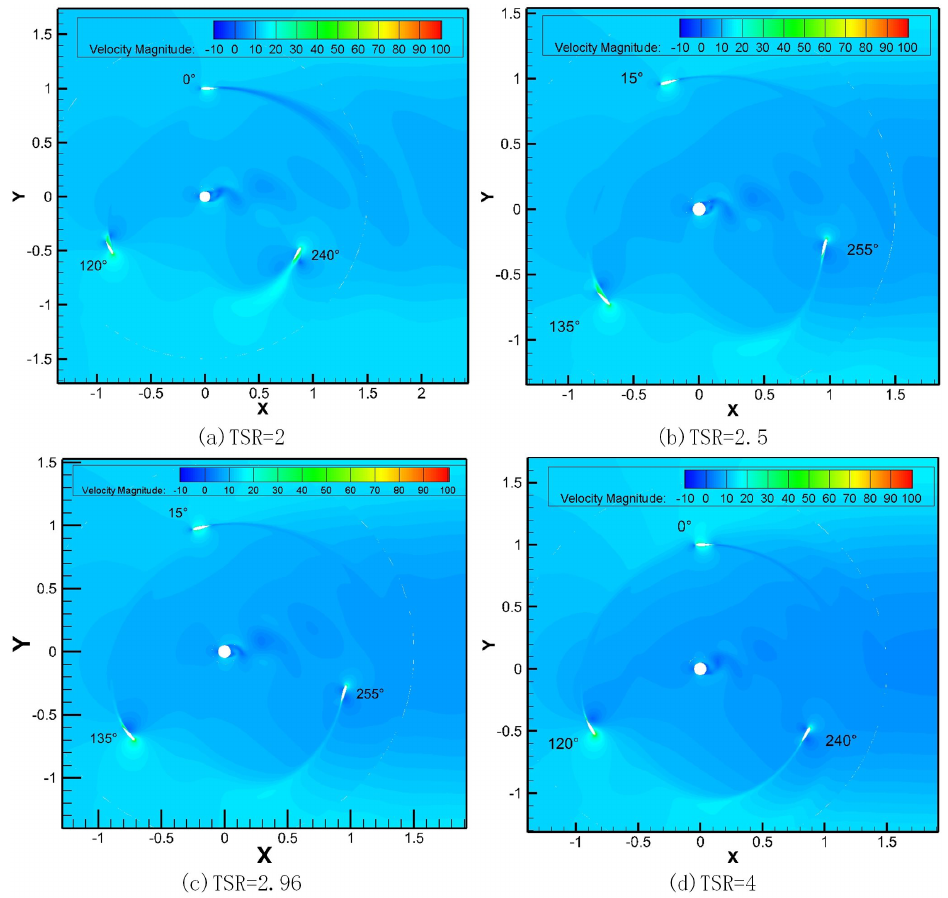
Figure 16. Velocity cloud diagram of two-dimensional wind generator with different